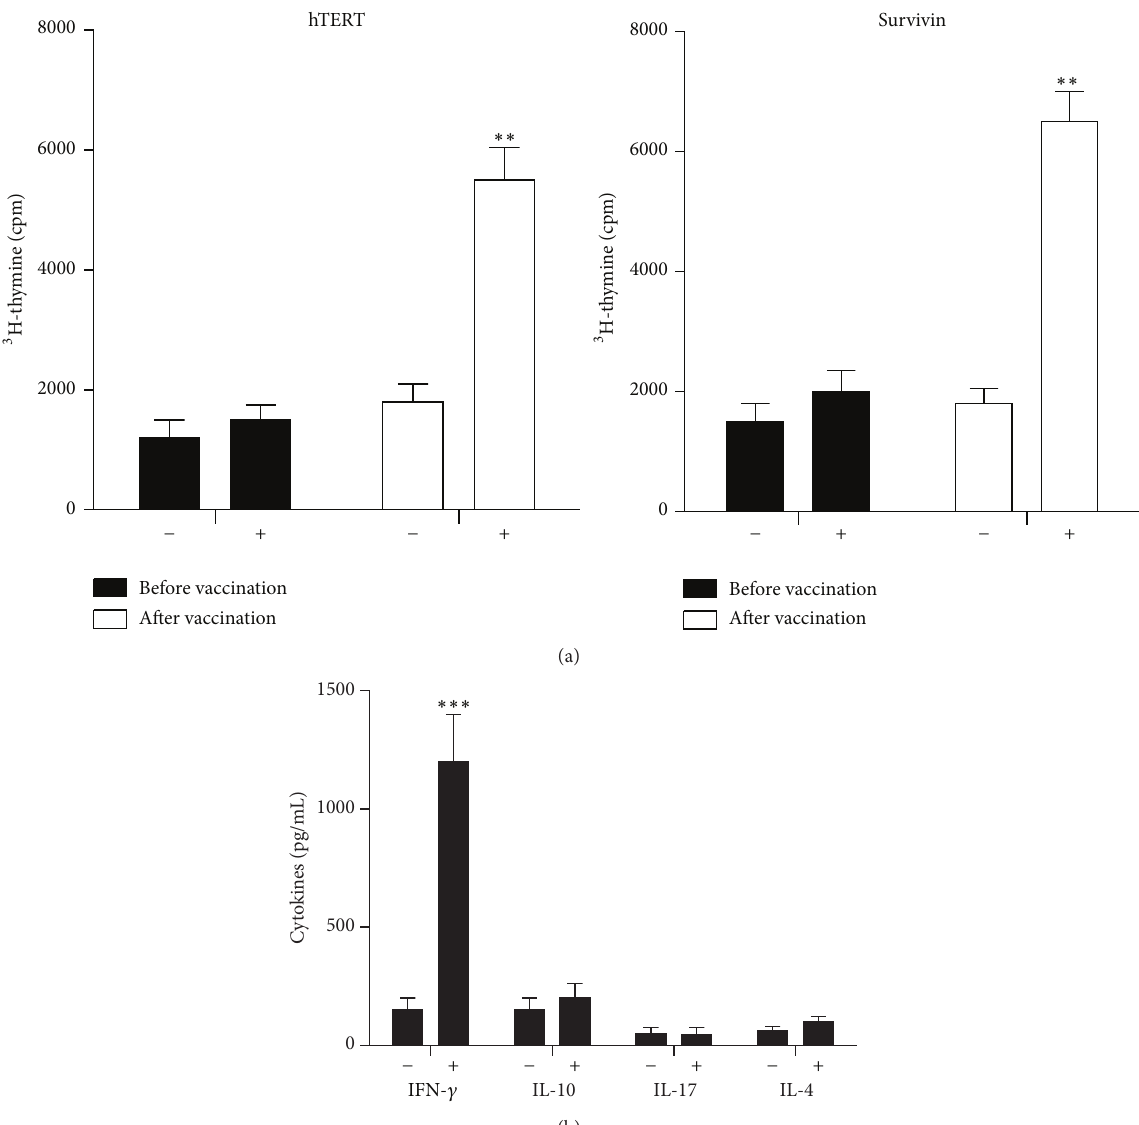
Figure 2: Analysis of T-cell responses to the vaccine. (a) T-cell responses to hTERT and survivin antigens prior to (week 0) and after (week 15) vaccination were analysed in PBMCs. The cells were not incubated ( − ) or were incubated (+) with recombinant hTERT or survivin protein (20 𝜇 g/mL) for 6 days, and T-cell proliferation was determined by incorporation of [ 3 H]-thymidine following overnight pulsing. The results are presented as the mean ± standard deviation of triplicate determinations. (b) Cytokine contents in culture supernatants. PBMCs were costimulated (+) or not ( − ) with recombinant survivin and hTERT (10 𝜇 g/mL each) for 5 days and then cytokine contents in culture supernatants were analysed by commercially available ELISA kits. The results are presented as the mean ± standard deviation of triplicate determinations. The data are representative of two independent experiments. PBMCs: peripheral blood mononuclear cells; IL: interleukin; IFN: interferon. ∗∗ 𝑃 < 0.02 and ∗∗∗ 𝑃 < 0.001